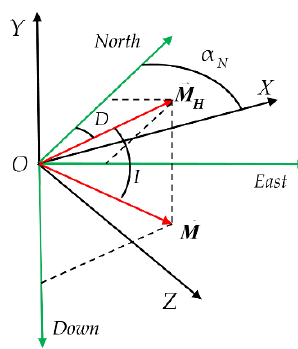
Figure 4. Orientation map of the reference coordinate system and geomagnetic vector.